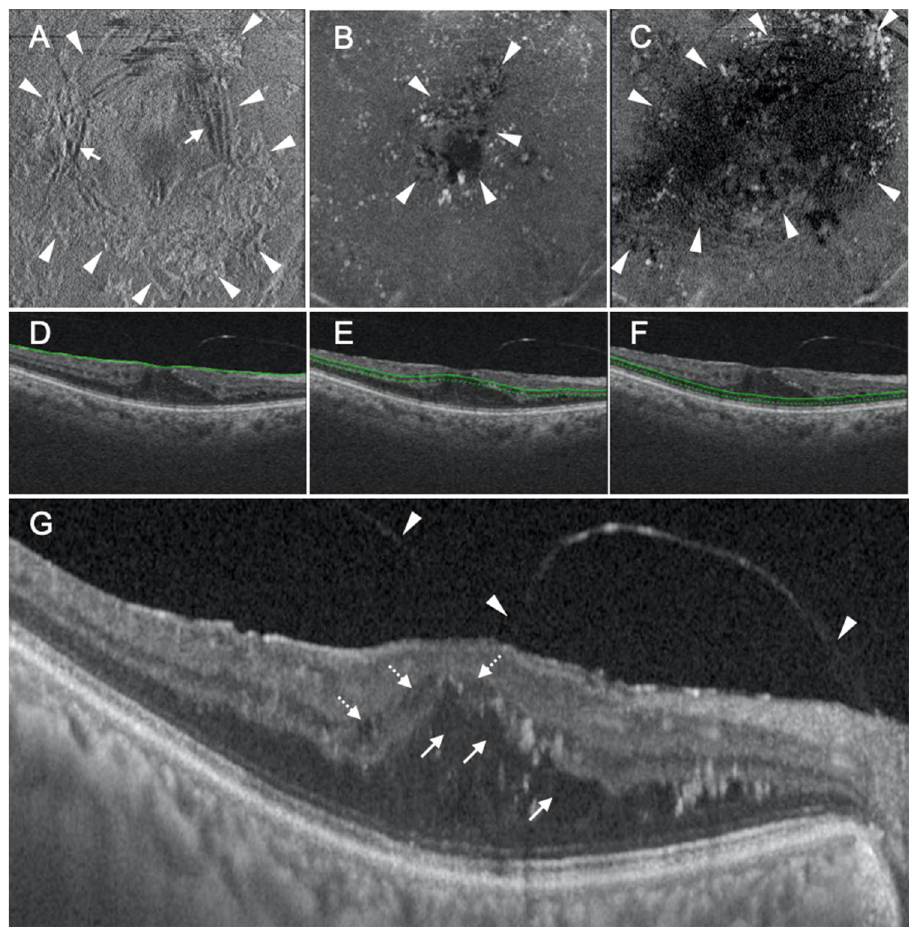
Figure 3. Representative case showing the parafoveal cystoid space at Segment 1/diffuse fluid at Segment 2 type of diabetic macular edema. ( A – C ) En face images of the retinal surface ( A ), Segment 1 ( B ), and Segment 2 ( C ) are presented. Epiretinal membrane (arrowheads in A) and associated retinal folds (arrows in A) can be observed at the surface of the retina ( A ). There are cystoid spaces at Segment 1, with the area of fluid remaining within the parafovea (arrowheads in B ). Segment 2 shows diffuse fluid (arrowheads in C ). ( D – F ) B-scan images and the green lines show the locations at which the en face images of the retinal surface ( D ), Segment 1 ( E ), and Segment 2 ( F ) were generated. The scan depth, indicated by the distance between the green line and green dotted line, was set to 0 μm for the en face image of the retinal surface ( D ) and 50 μm for the en face images of both Segments 1 and 2 ( E , F , respectively). ( G ) A horizontal B-scan image centered at the fovea is presented. There are parafoveal cystoid spaces at both Henle’s fiber layer (arrows in G ) and the inner nuclear layer (dotted arrows in G ). The fluid at Segment 2 observed on the en face image is not clearly visualized on this cross- sectional image. The arrowheads in ( G ) show incomplete posterior vitreous